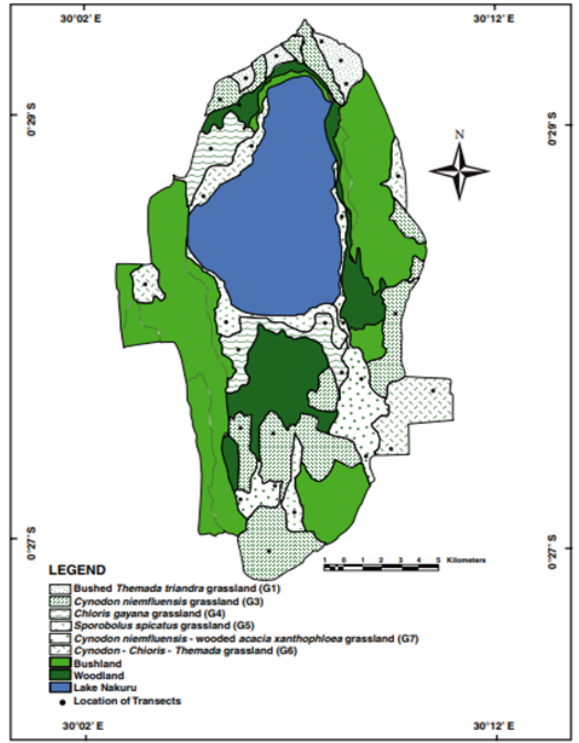
Figure 4: Distribution of vegetation classes in Lake Nakuru Na- tional Park (illustration from (Ng’weno et al.,